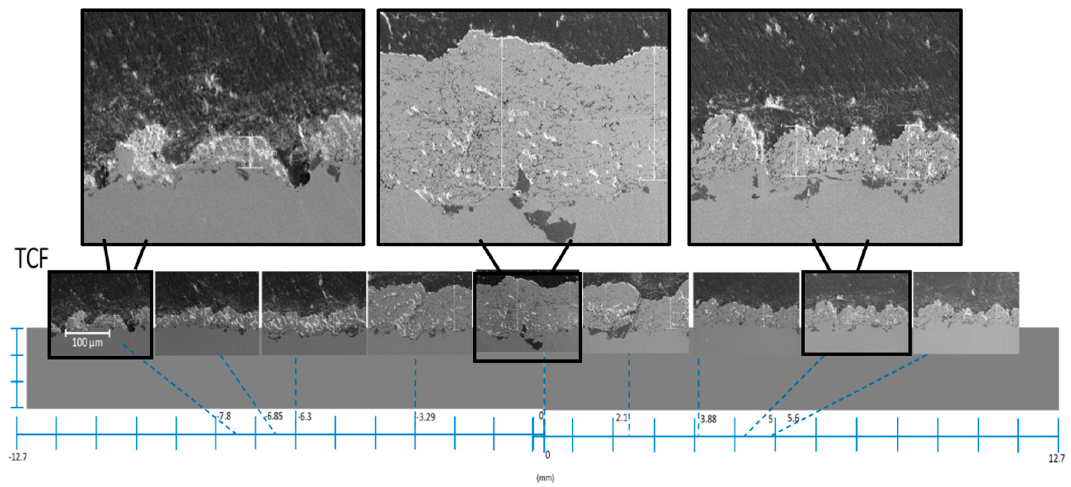
Figure 11. Metallographic SEM images of the coating cross-section deposited on the flat coarse grit-blasted substrate (TCF) and recorded at different locations along the substrate surface.